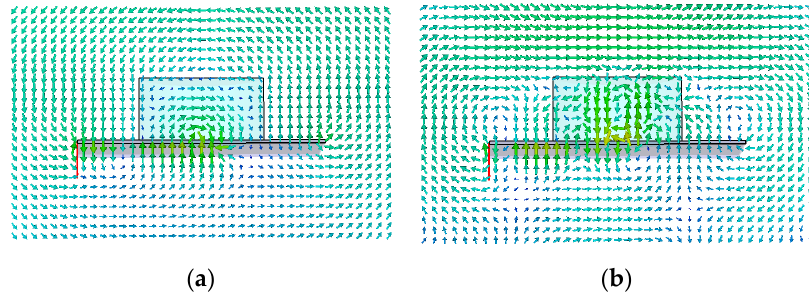
Figure 3. Electric field distributions on the x ‐ z plane: ( a ) 2.45 GHz; ( b ) 5.8 GHz.